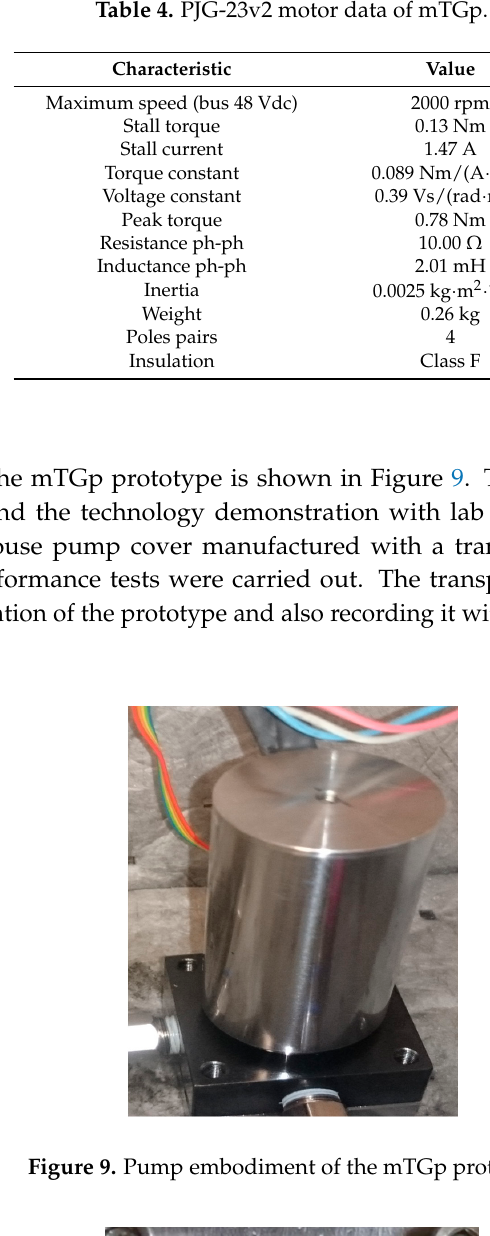
Table 4. PJG-23v2 motor data of mTGp.